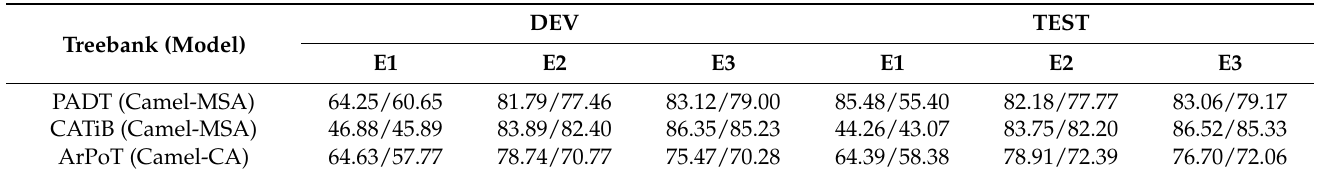
Table 7. Average UAS/LAS over 5 runs on development (DEV) and test datasets using three head position